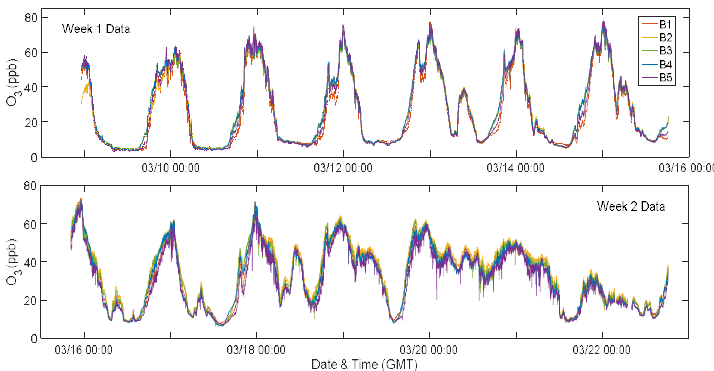
Figure A4. Time series of co-located ( top ) and deployed ( bottom ) Y-Pods, for examining building-scale variability of CO 2 . Sensors 2018 , 18 , x FOR PEER REVIEW